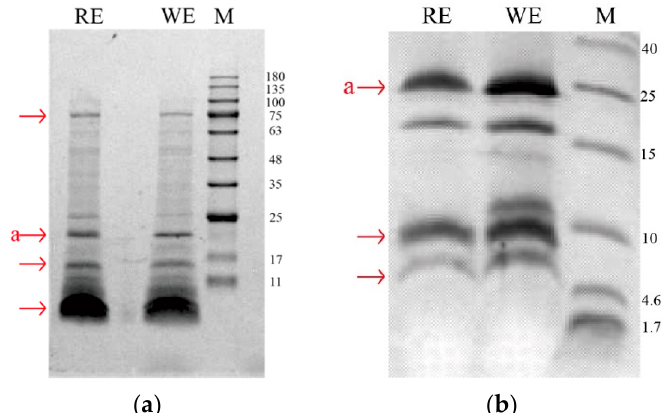
Figure 1. Separation on 4~20% Tris–Gly–SDS and 16.5%Tris–tricine polyacrylamide gels of white- and red-fleshed pitaya seeds protein extract. Lanes WE and RE correspond to white- and red-fleshed pitaya seeds protein extraction, respectively. Lane M: corresponds to protein markers and their corresponding molecular masses (kDa). Major protein bands are marked by red arrows: ( a ) pitaya seeds protein composition analysis by 4~20% Tris–Gly–SDS polyacrylamide gel and ( b ) pitaya seeds protein composition analysis by 16.5%Tris–tricine polyacrylamide gel.